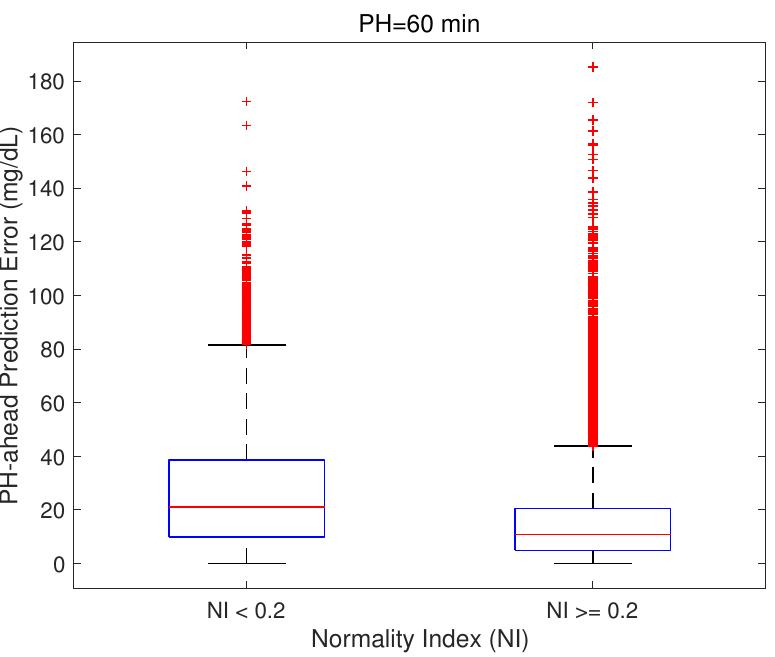
Figure 8. Boxplot of absolute value of the residual at t p + PH grouped by Normality Index value for a threshold of 0.2. Difference of the median was statistically significant by Wilcoxon Rank Sum test ( p <